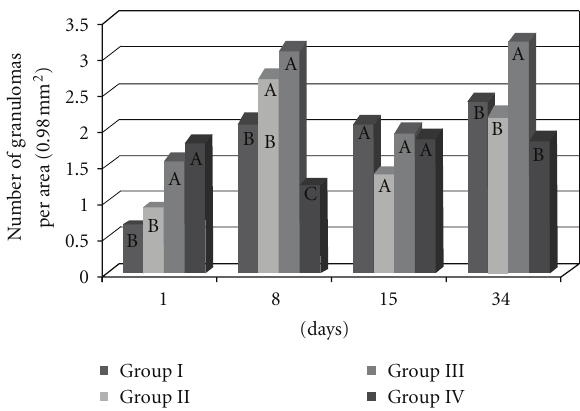
Figure 6: The number of lung granulomas of the mice that were inoculated with eggs of the S. mansoni BH (Group I) or SJ (Group II) strains and of those that were previously infected with the S. mansoni BH strain and then inoculated 8 weeks later with eggs from the S. mansoni BH (Group III) or SJ (Group IV) strains. The mice were euthanized 1, 8, 15 or 34 days after inoculation with the eggs. At each time point, the means depicted with the same letter do not di ff er significantly ( α = 0 . 05).